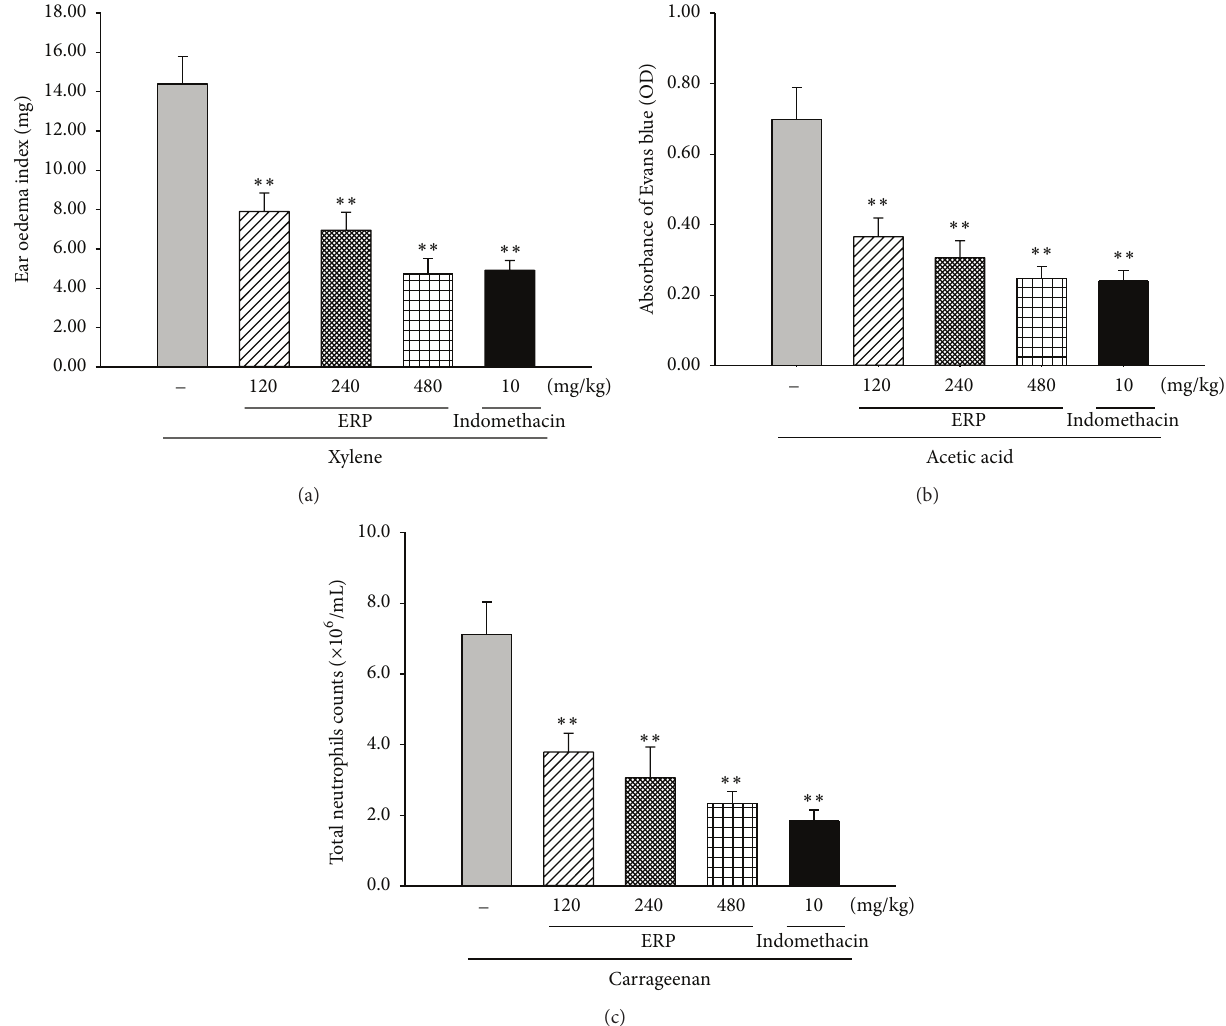
Figure 2: Inhibitory effect of ERP on the xylene-induced mouse ear edema (a), the acetic acid-induced mouse capillary permeability (b) and carrageenan-induced mouse pleurisy (c). (a) The ear edema was represented as the ear edema index which was assessed as the weight difference between the right and the left ear biopsies of the same animal. (b) The capillary permeability was represented by the amount of Evans blue extruded into peritoneal cavity, which was measured by the OD of the supernatant. (c) The pleurisy was represented by neutrophils counts in the inflammatory site. Data was represented as the mean ± S.E.M. ( 𝑛 = 10 ). ∗ 𝑃 < 0.05 and ∗∗ 𝑃 < 0.01 compared to the xylene- control group (a), acetic acid-control group (b) and carrageenan-control group (c).